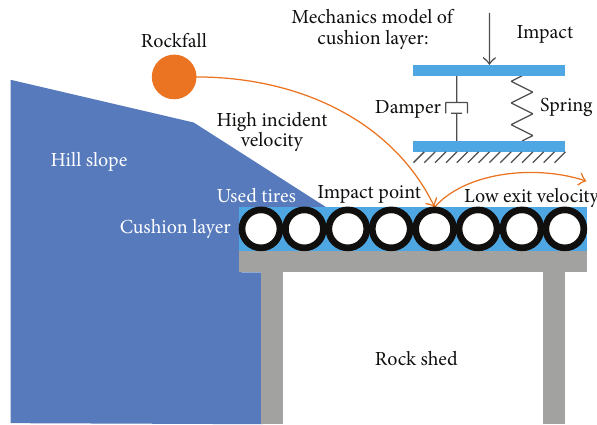
Figure 3: Schematic of used tire cushion layer.